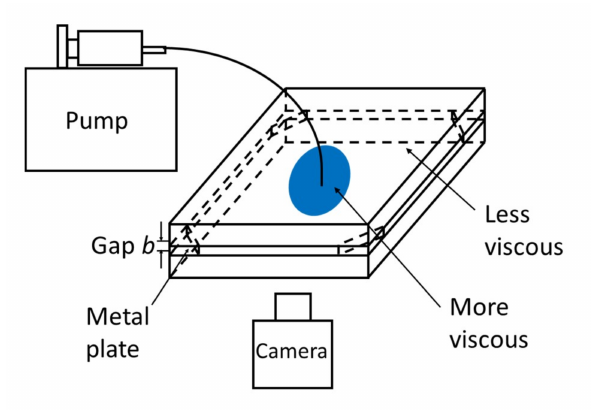
Figure 4. The schematic for the hydrodynamically stable